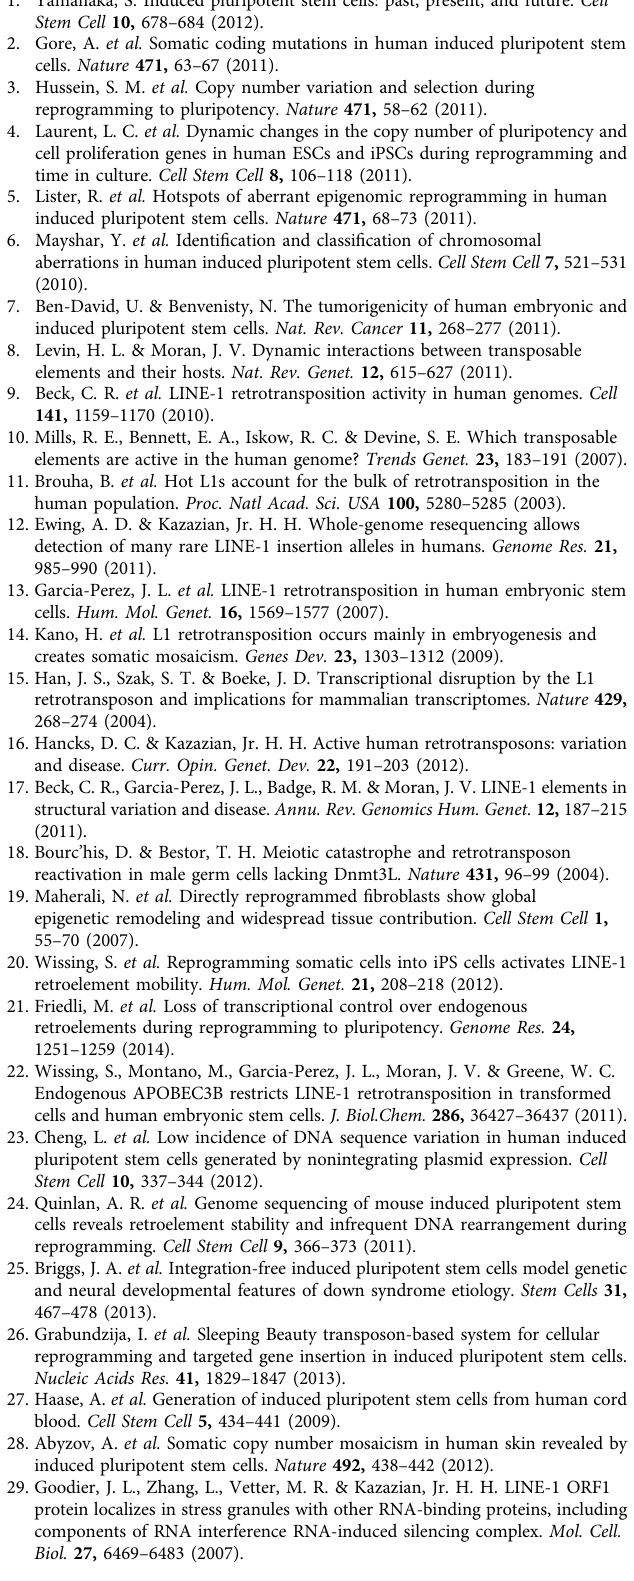
Supplementary Table 3. PCR products were visualized on a 1.5% agarose gel after ethidium bromide staining. L1 retrotransposition reporter assays . De novo full-length L1 insertions were amplified from genomic DNA using an Expand Long Template PCR system (Roche) and primers located 50bp upstream/downstream the insertion site (available upon request). For each PCR we used: 0.3 m l Expand Long Template